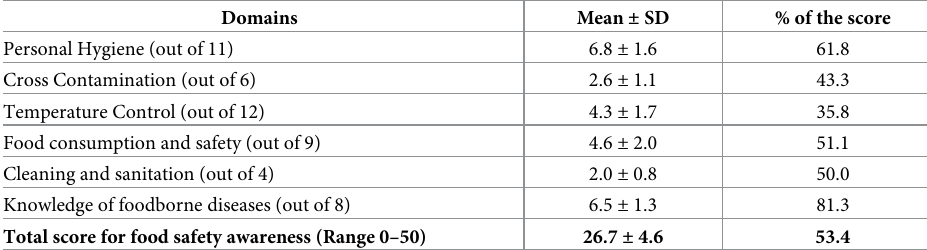
Table 2. Food safety score for study participants (n = 354).